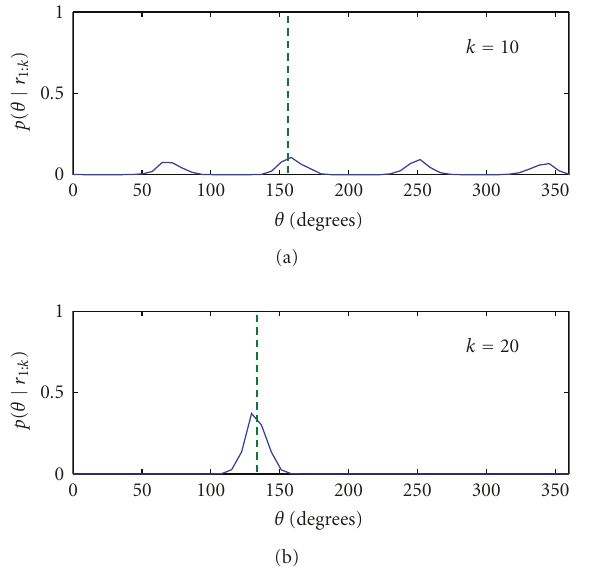
Figure 1: Histogram of p ( θ | r 1: k ) ↔ { (cid:12) θ ( j ) ; (cid:12) w ( j ) } obtained by the phase-based sampling algorithm ( σ 2 QPSK). The dashed line indicates the true value of θ k .